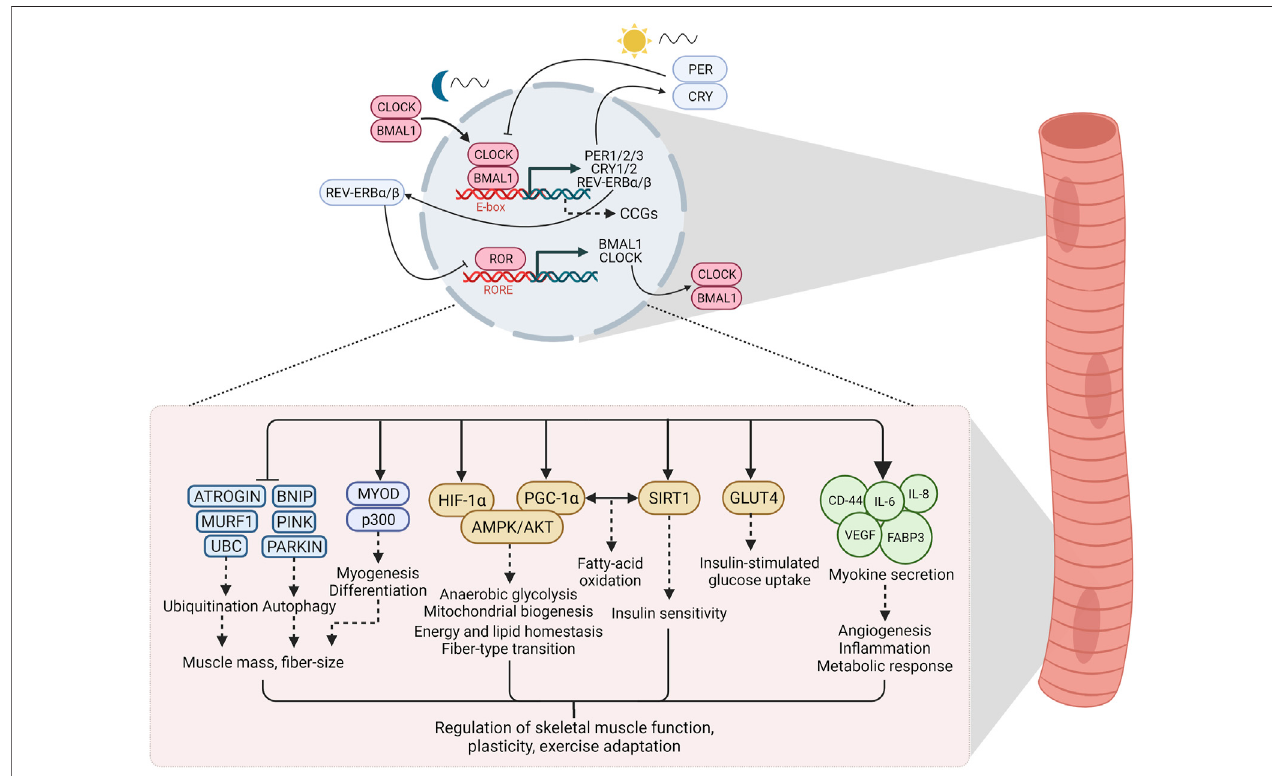
FIGURE 1 | The circadian clock and downstream signaling in skeletal muscle. Clock factors regulate the expression of hundreds of genes, often termed clock- controlledgenes(CCGs),outsideofthecircadianfeedbackloop.Inskeletalmuscle,thesedownstreamtargetsareinvolvedinahostofsignalingprocessesthatregulate skeletalmusclefunction,plasticityandadaptationtoexercise.Seetextfordetails.Abbreviations:CLOCK,CircadianLocomotorOutputCyclesKaput;BMAL1,Brainand Muscle ARNT-Like 1; PER, Period; CRY, cryptochrome circadian regulator; ROR, retinoic acid-related orphan receptors; RORE, ROR/REV-ERB-response element; CCGs, clock controlled genes; UBC, Ubiquitin C; MURF1, Muscle RING- fi nger protein-1; BNIP, BCL2 Interacting Protein; MYOD, myoblast determination protein; HIF-1 α , hypoxia-inducible factor 1 α ; PGC-1 α , peroxisome proliferator-activated receptor γ coactivator 1 α ; AMPK, AMP/ADP-dependent protein kinase; AKT, Protein kinase B; SIRT1, Sirtuin 1; GLUT4, Glucose transporter type 4; CD-44, cluster of differentiation 44; IL-6, Interleukin 6; IL-8, Interleukin 8; VEGF, vascular endothelial growth factor; FAPB3, fatty acid binding protein 3. Created with